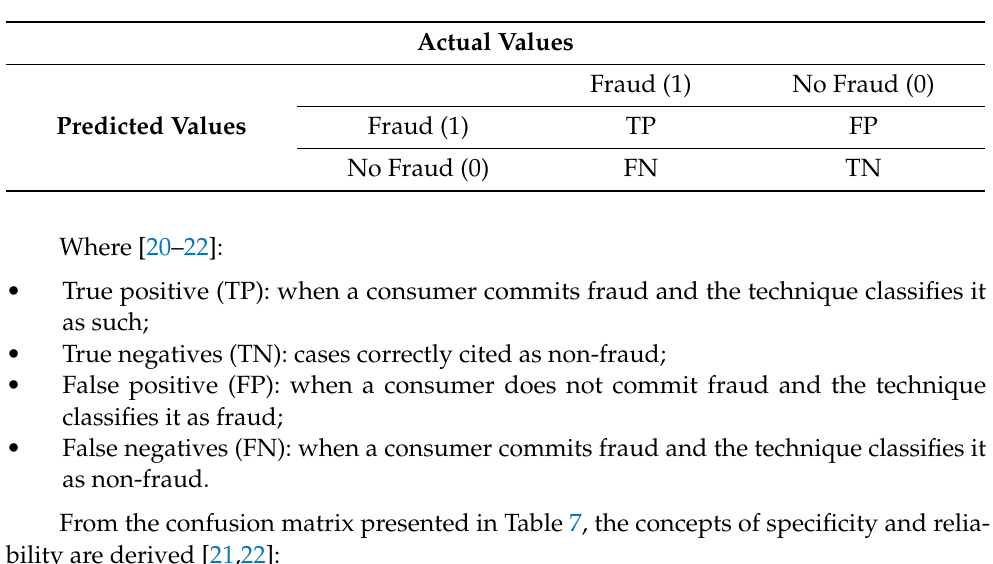
Table 7. Confusion